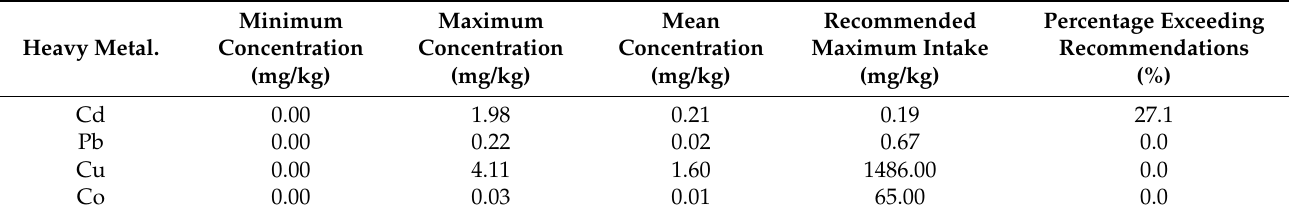
Table 4. PTEs concentrations in rice grain.